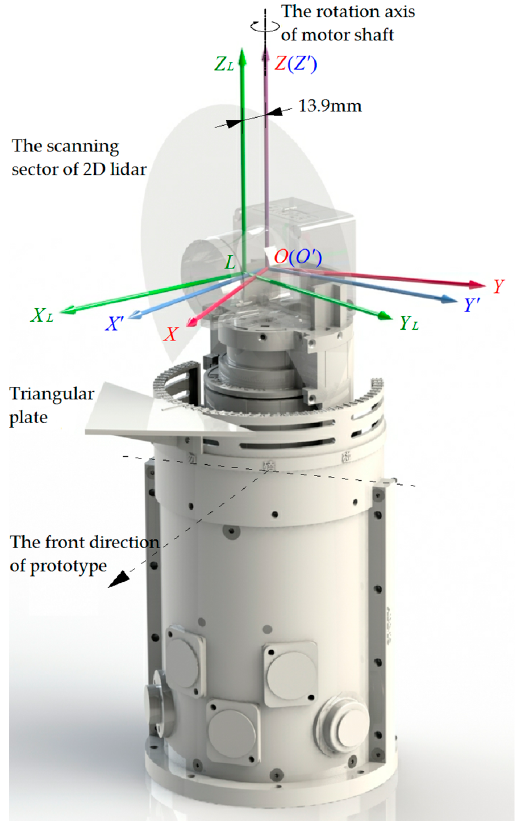
Figure 4. Three Cartesian coordinate frames. The coordinate frame of the 2D lidar ( L ) is shown in green, the coordinate frame of rotating unit before attitude correction ( O’ ) is shown in blue, and the coordinate frame of rotating unit after attitude correction ( O ) is shown in red.